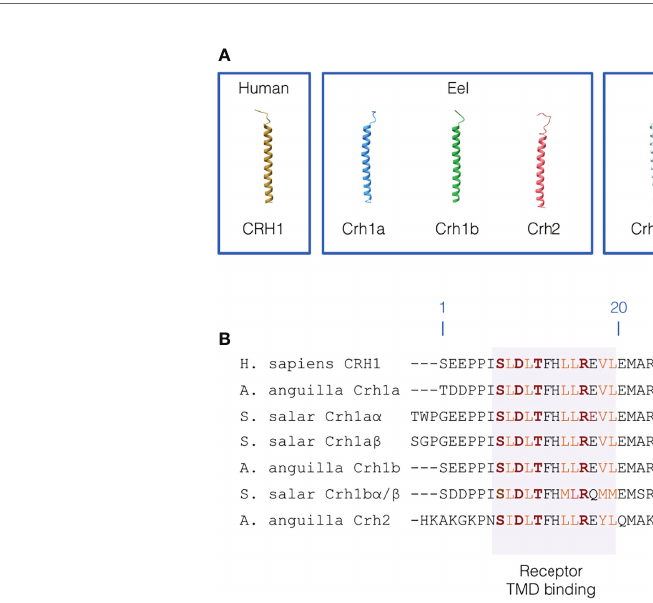
FIGURE 5 | Primary and 3D structure of CRH peptides. (A) 3D structure of human CRH1 peptide, and the three CRH peptides (3R-Crh1a and b, Crh2) in European eel and four CRH peptides (4R-Crh1a a and a b , 4R-Crh1b a /b b which have the same sequence) in Atlantic salmon. CRH peptide structures were modelled using iTASSER. (B) Sequence alignment of human CRH1, eel 3R-Crh1a and b and Crh2, and Atlantic salmon 4R-Crh1a a , a b , and 4R-Crh1b a /b b . Residue numbering are based on human CRH1. The region of CRH peptides interacting with the CRH receptor transmembrane domain are highlighted in light purple and the region of CRH peptides interacting with the CRH receptor extracellular domain are highlighted in orange. Conserved hydrophobic residues involved in the receptor binding are indicated in orange and the residues involved in electrostatic interaction with the receptor are indicated in red and